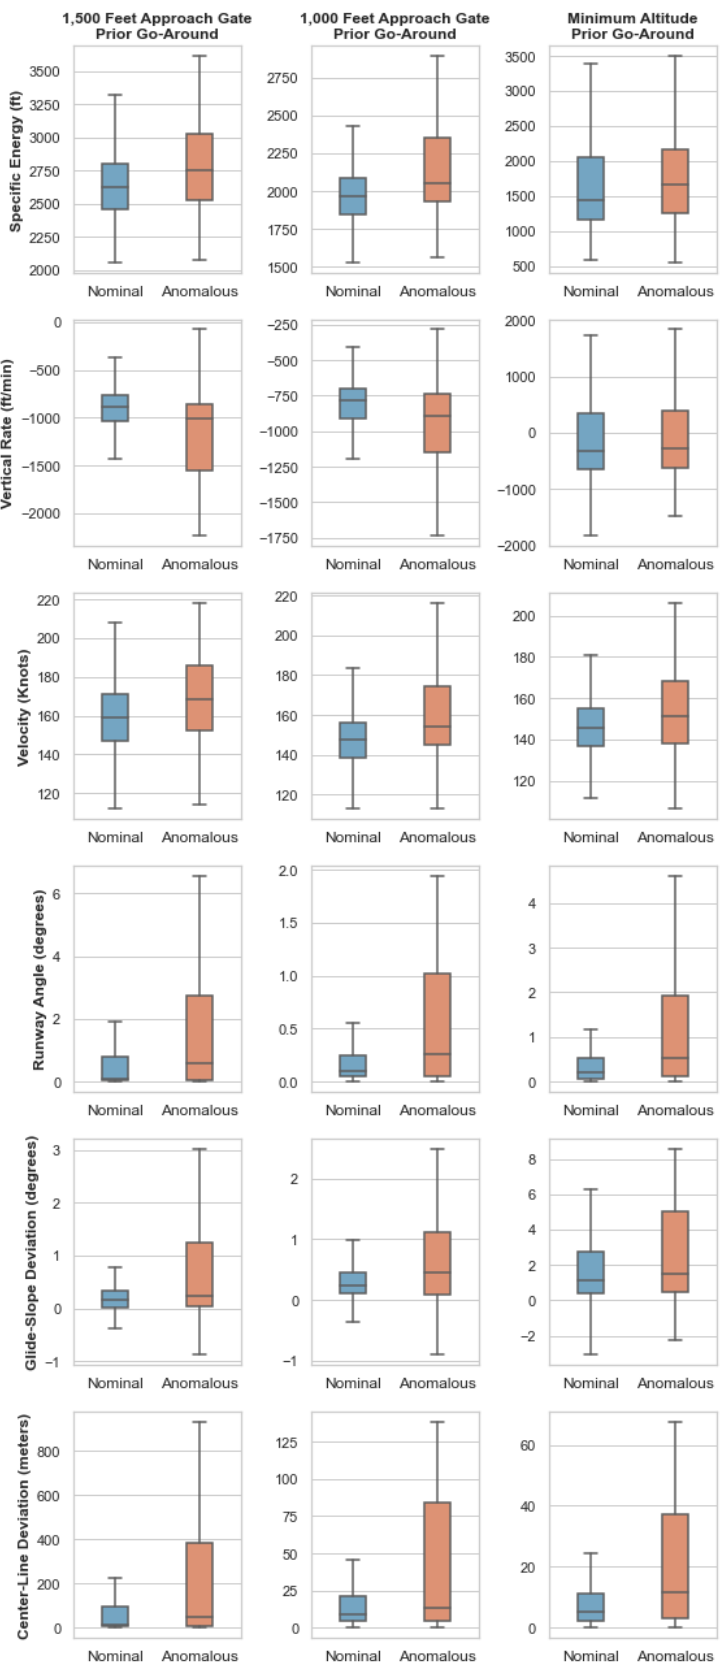
Figure 7. Box-plots of different features at points prior to the